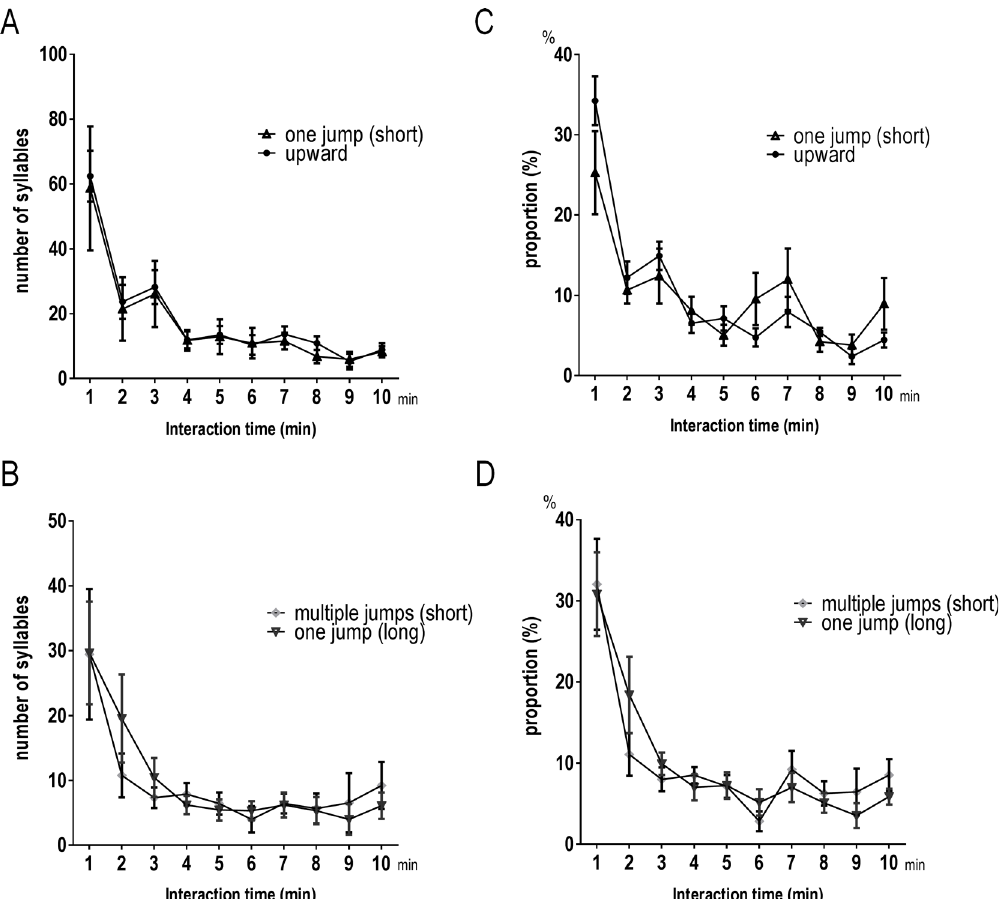
Fig 5. Temporal changes of four syllable types during male – female interaction. Temporal changes in the number of syllables (A and B) and the proportion (C and D) of four syllable types over 10 min. The changes in the number and proportion were similar between Upward and One jump (short), and between One jump (long) and Multiple jumps